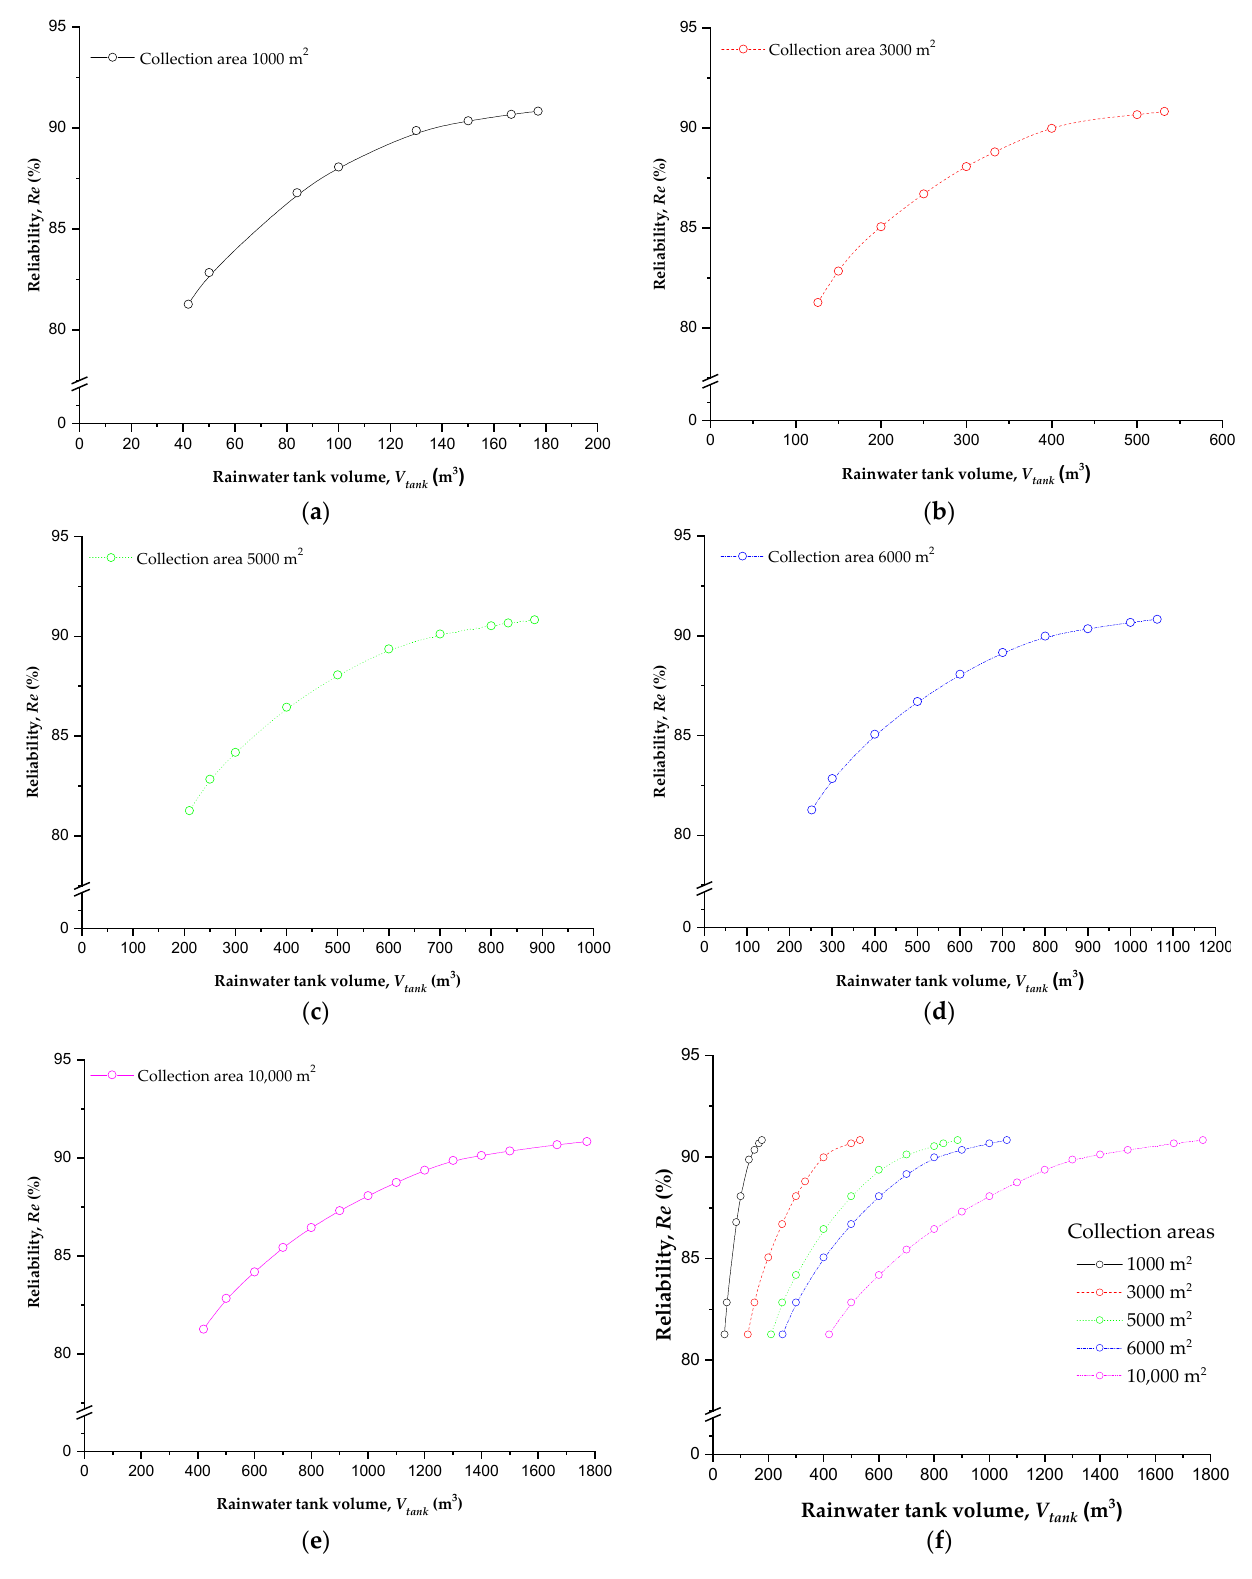
Figure 7. Reliability curves of covered rainwater harvesting system in relation to tank sizes to meet the demand of a tomato crop cultivated in greenhouses with rainwater collection areas: ( a ) 1000 m 2 ; ( b ) 3000 m 2 ; ( c ) 5000 m 2 ; ( d ) 6000 m 2 ; and ( e ) 10,000 m 2 . A comparative presentation was also presented ( f ).